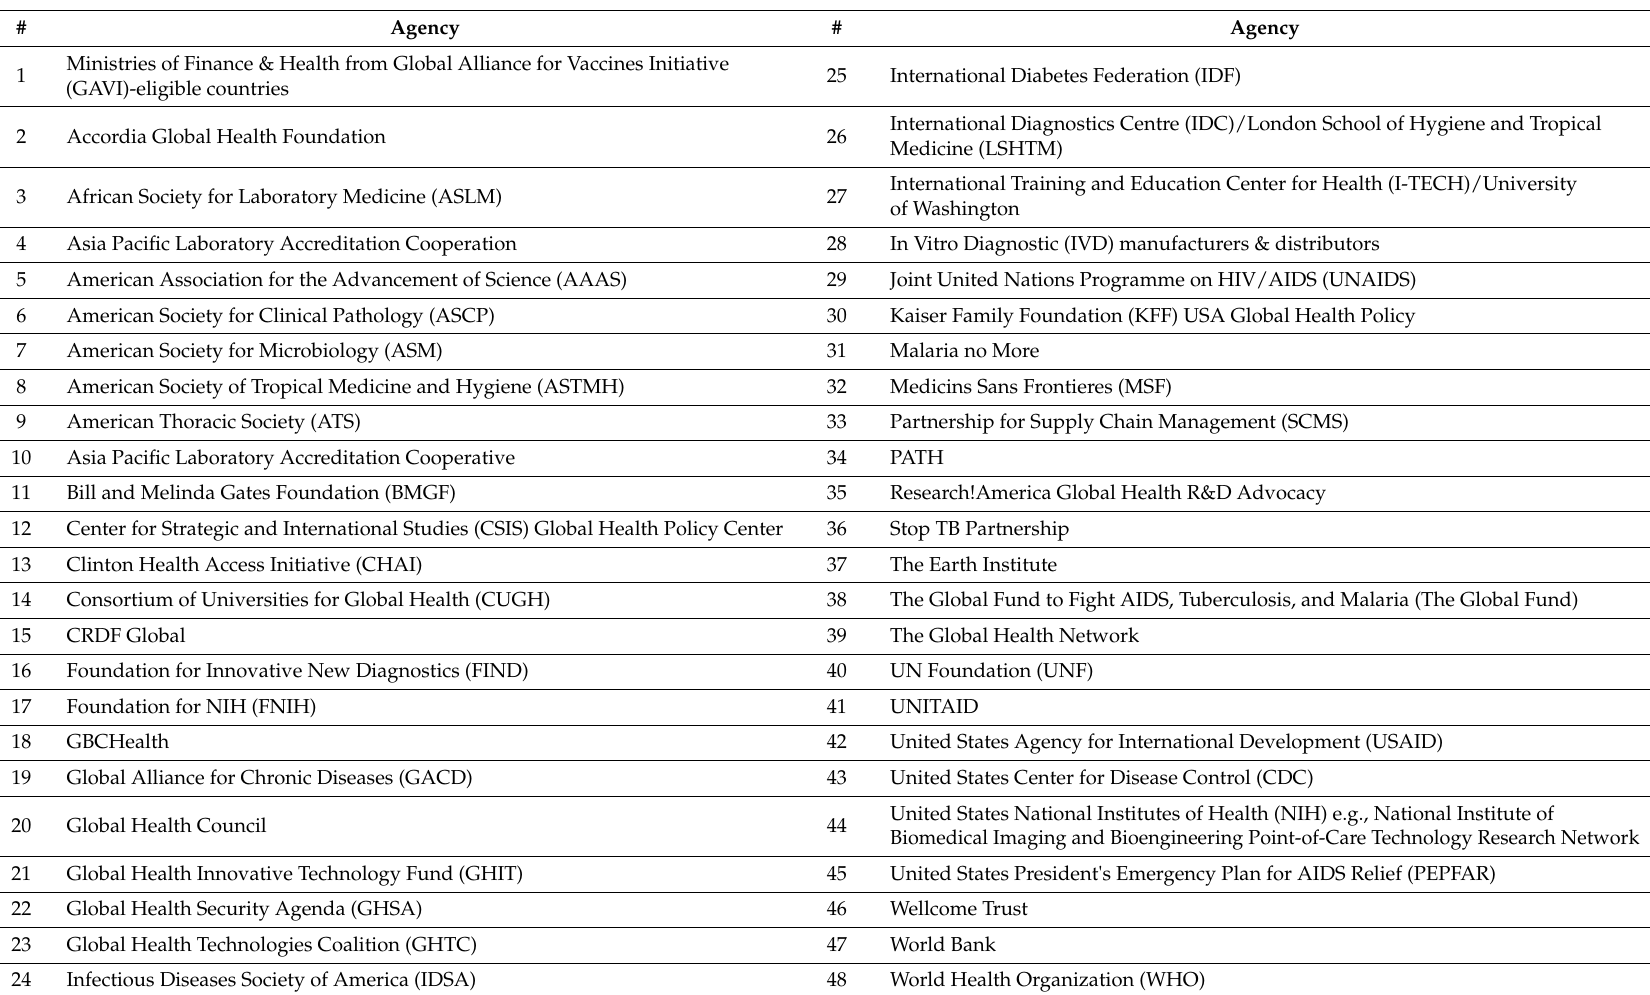
Table 1. Partners in the Global Medical Diagnostic